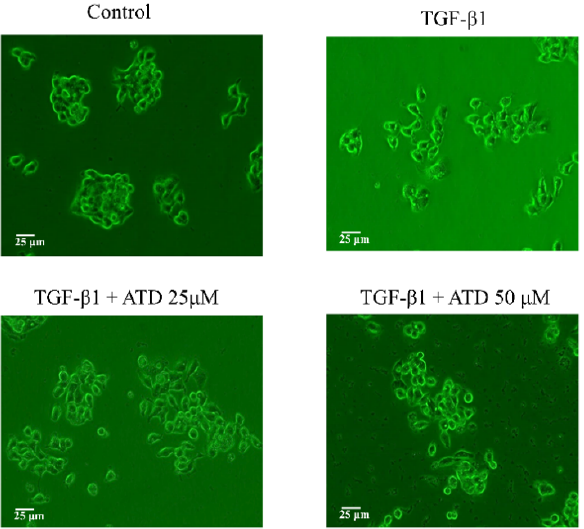
Figure 6. Reverse effect of ATD on TGF- β 1-induced cell scattering in HepG2 hepatoblastoma cells. The cell was applied with or without (control group) TGF- β 1 for 24 h, and then TGF- β 1 co-treated with or without ATD for an additional 24 h. The cell was observed under phase contrast microscopy (200 × ) and photographed.